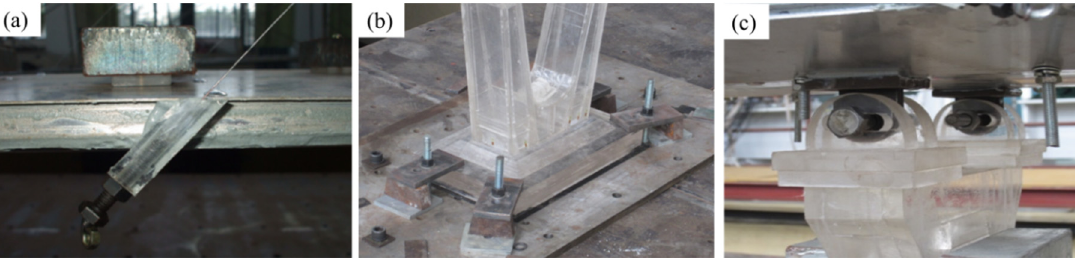
Figure 5. Assembling of the components ( a ) cable anchor; ( b ) fixed tower foundation platform; ( c ) sliding bearing.